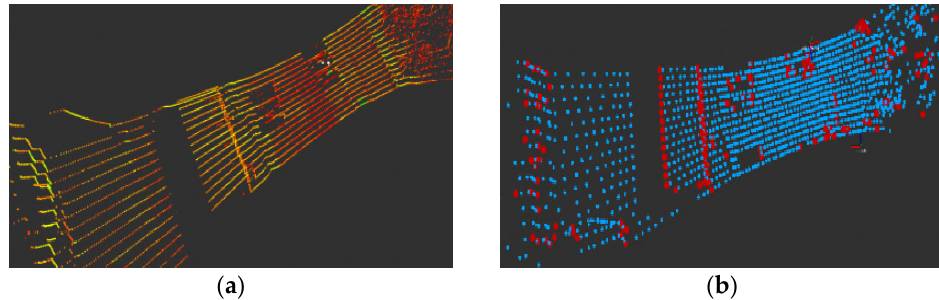
Figure 2. An example of extracted key points: ( a ) A single LiDAR frame; and ( b ) Extracted edges (red) and planes (blue).